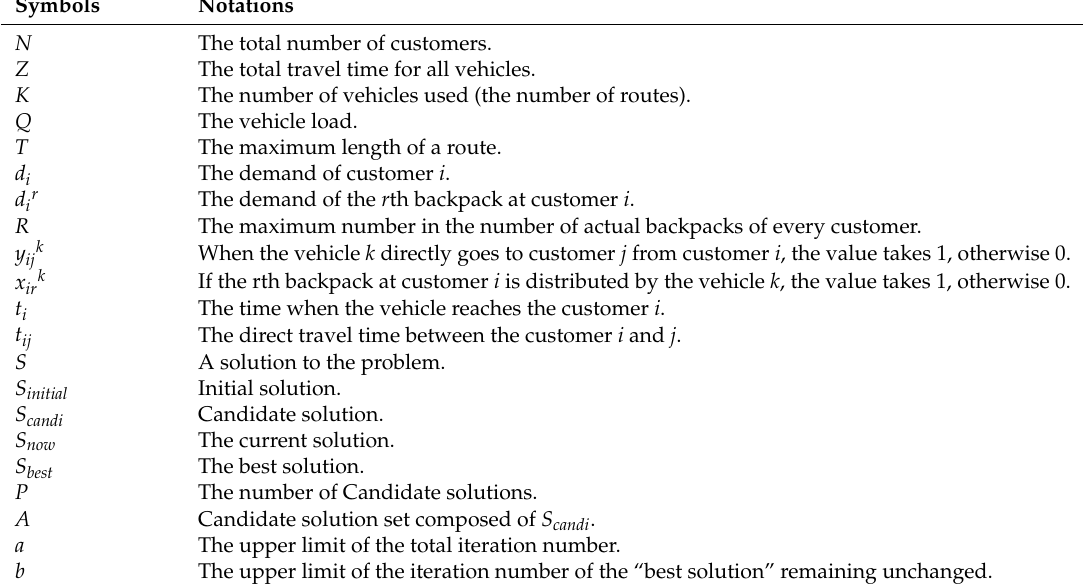
Notations of the capacitated vehicle routing problem with split deliveries by backpack